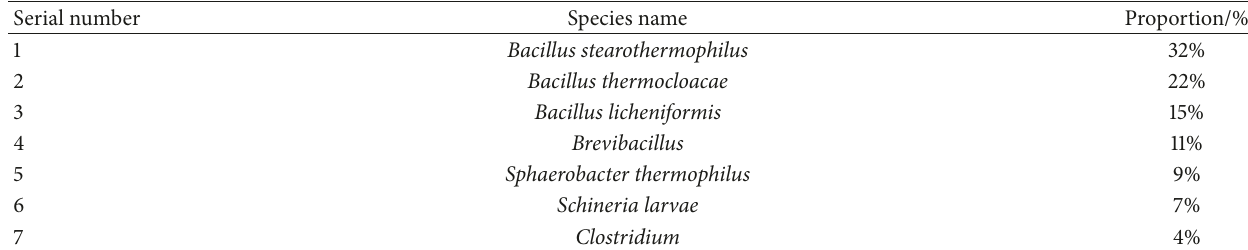
Table 4: ATAD reactor strain